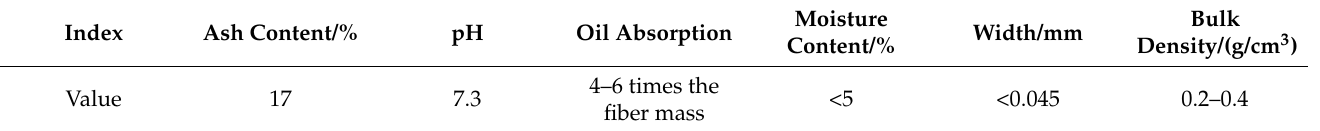
Table 4. Technical indicators of lignin